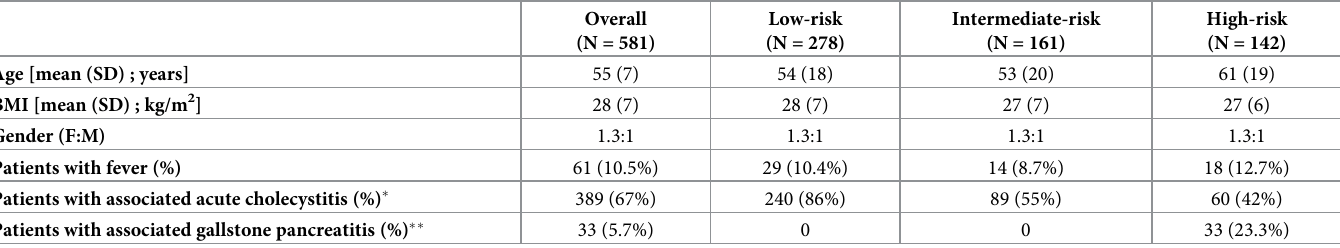
Table 1. Baseline characteristics.